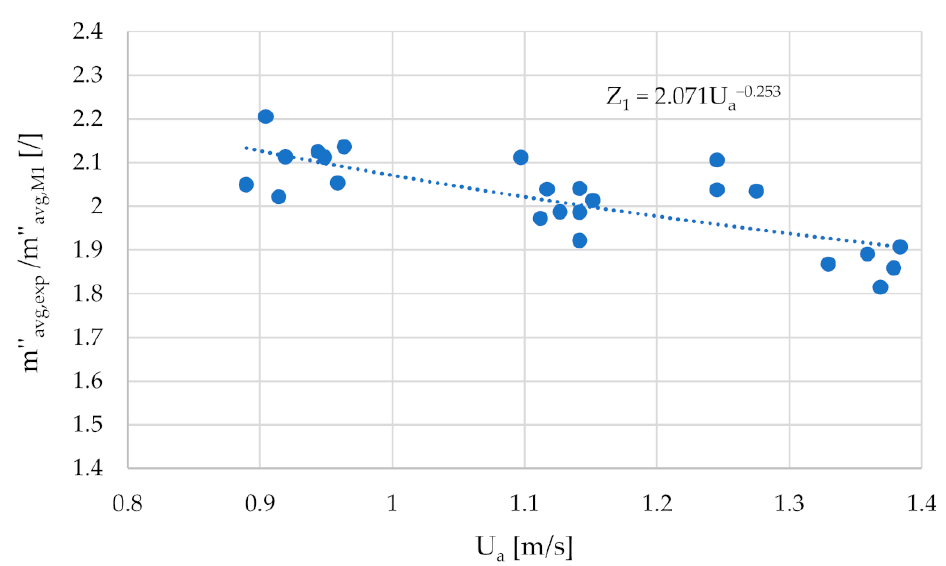
Figure 7. Dependence of the ratio of the experimental and calculated condensation mass flux on the inlet velocity of the bulk flow of humid